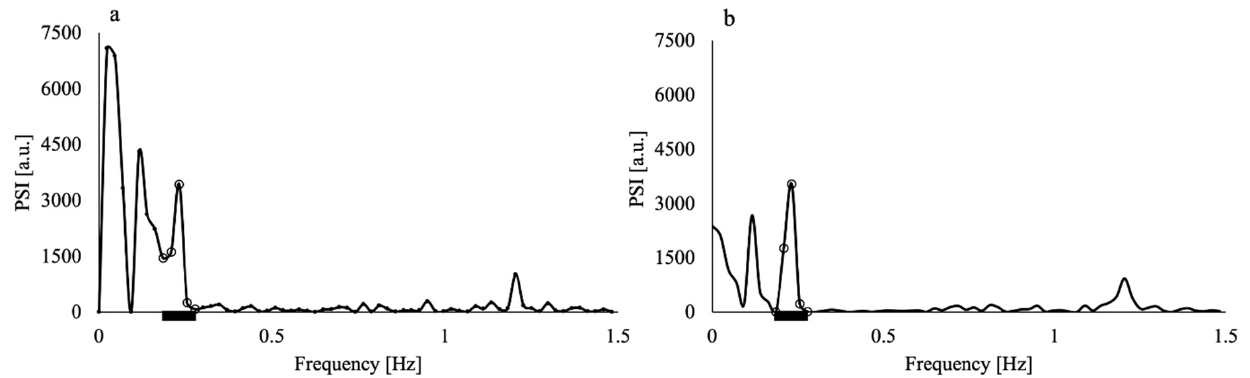
Figure 2. Power spectral intensity (PSI) of the time series MR signal of the superior sagittal sinus of a non ‐ smoker volunteer ( a ) before and ( b ) after application of the Hamming window. The PSI values in ( b ) were multiplied by the square of the correction factor (1.59) of the Hamming window. Both MR signals were obtained through imaging with 15 mm slice thickness. Black thick bars represent the respiratory frequency range. The open circles represent the data in the respiratory frequency range (0.2–0.3 Hz).